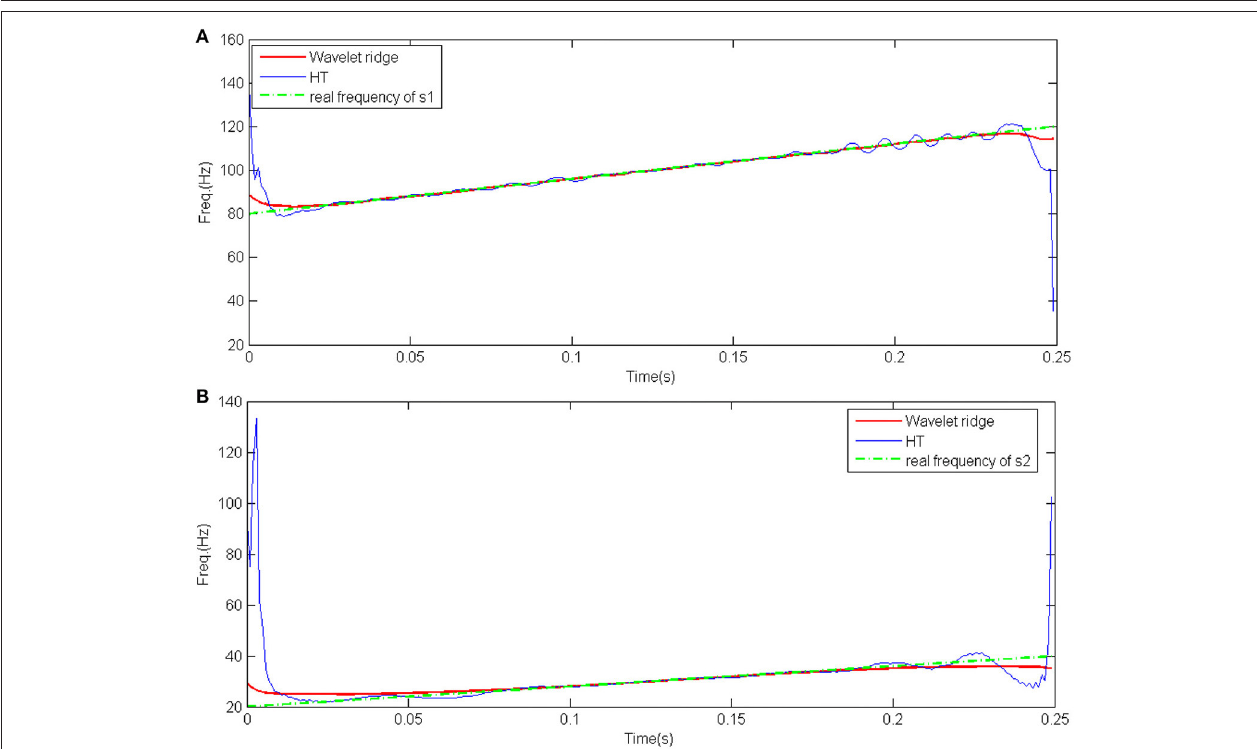
FIGURE 4 | IF extraction of the two IMFs using wavelet ridge and HT without adding Gaussian white noise. (A) IF of the IMF1. The real frequency of s 1 (t) is plotted in green color. (B) IF of the IMF2. The real frequency of s 2 (t) is plotted in green color.